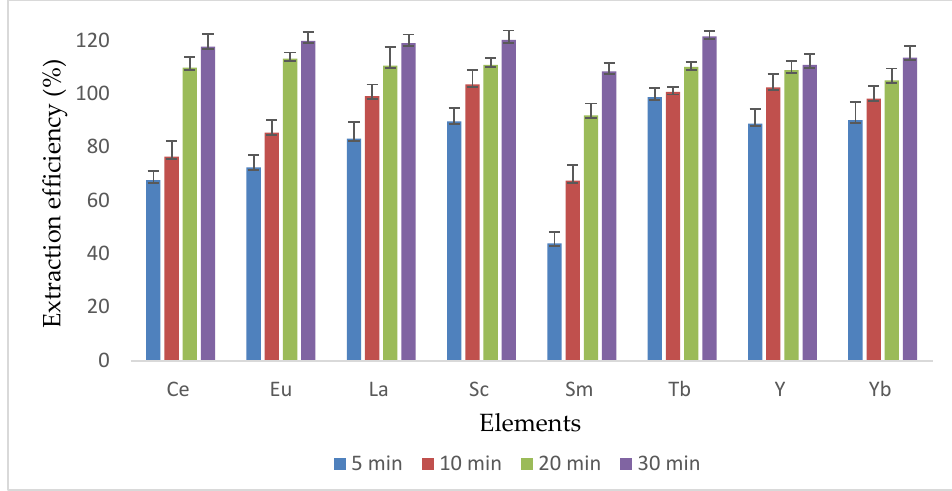
Figure 3. Effects of different ultrasound extraction times (5, 10, 20, and 30 min) for the extraction of REEs in coal samples. UAE conditions: [HNO 3 ] (1 mol L −1 ), sample mass (0.1 g), extraction time (optimized), UAE temperature (80 °C), UAE frequency (high), and replicates ( n = 3).